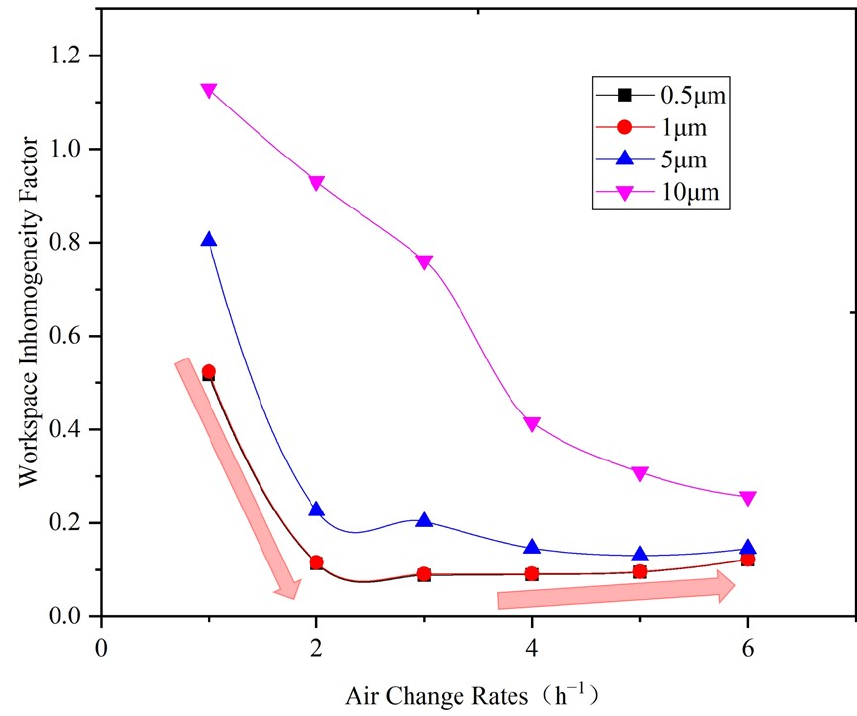
Figure 10. Relationship between the workspace inhomogeneity factor and air change rate.